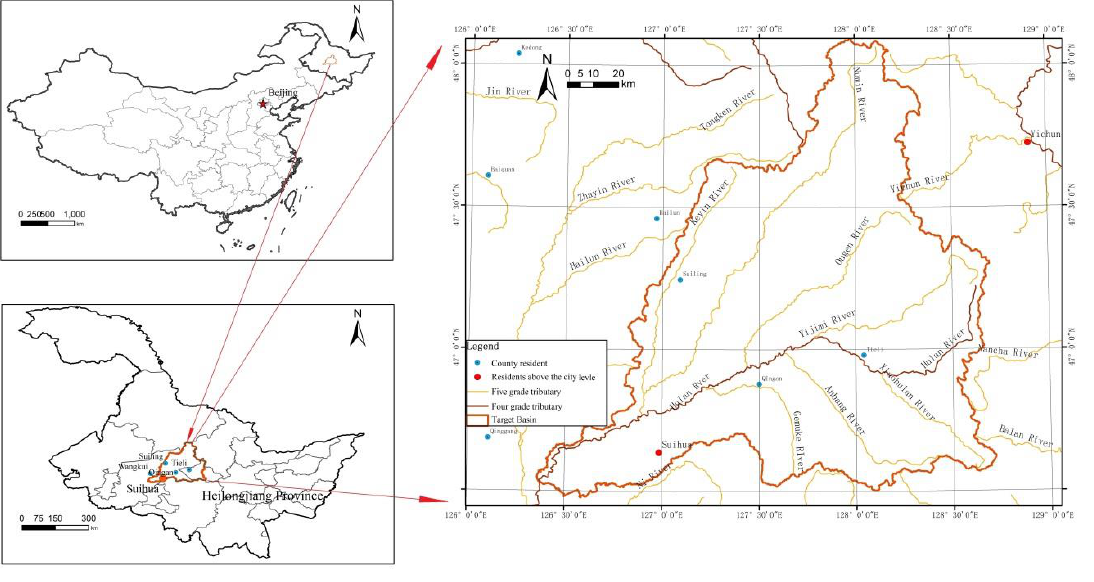
Figure 1. Location of the study area.